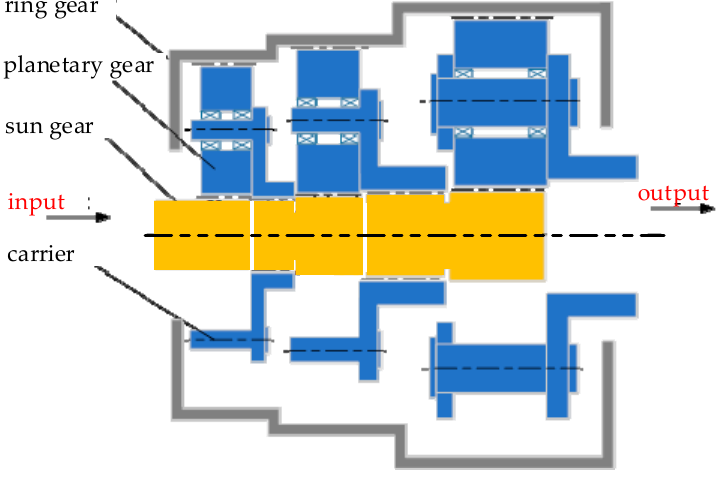
Figure 2. The connection of the planetary gear system.